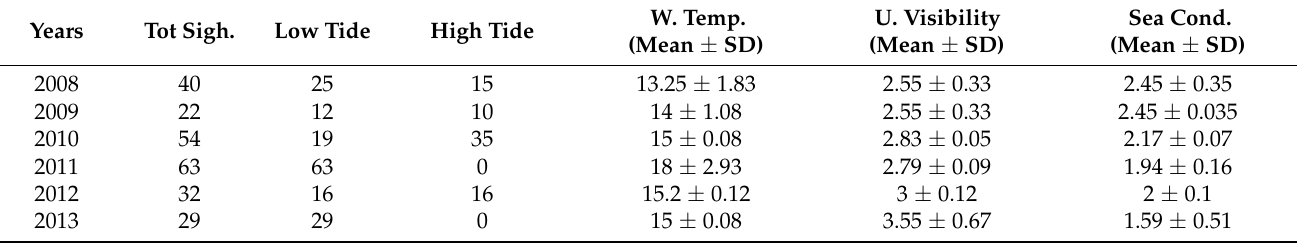
Table 5. Summary and descriptive table for the average individual (total sightings) over time. Here, ‘Tot. Sigh.’ stands for total sightings, and ‘W. Temp.’, ‘U. Visibility’, and ‘Sea Cond.’ refer, in average ± SD, to water temperature ( ◦ C), underwater visibility (m), and sea conditions, respectively. The ranges would correspond to the minimum and maximum values displayed in the